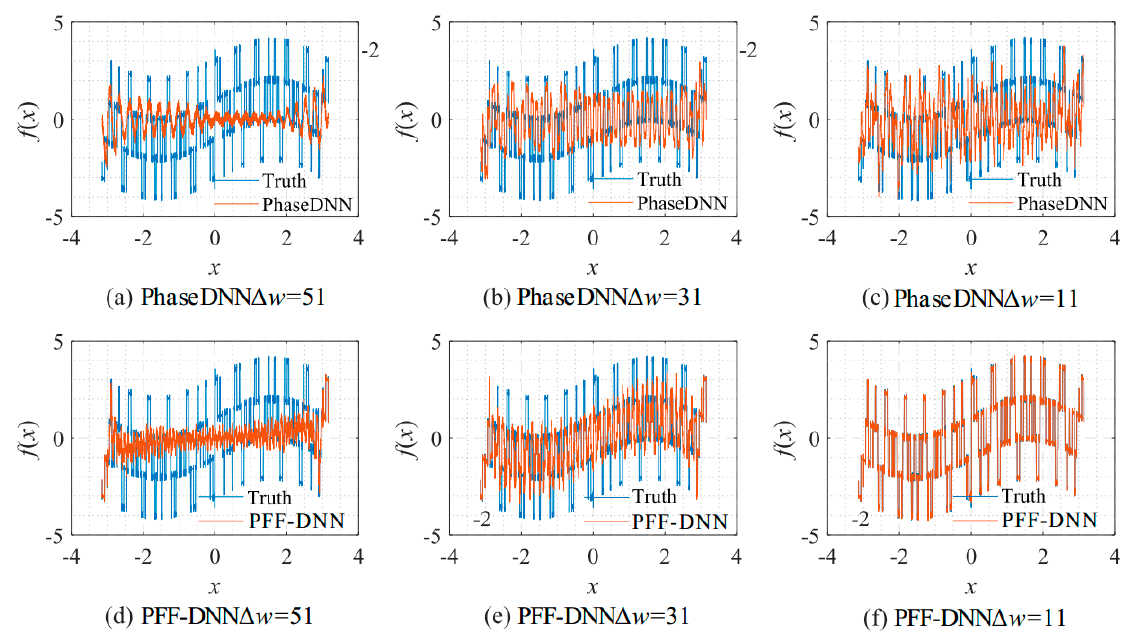
Figure 24. The influence of Δ ω on the algorithm performance. The fitting results of the PhaseDNN method after 10,000 updates: ( a ) Δ ω = 51; ( b ) Δ ω = 31; and ( c ) Δ ω = 11. The fitting results of the PFF-DNN method after 10,000 updates: ( d ) ∆ ω = 51; ( e ) ∆ ω = 31; and ( f ) ∆ ω = 11.